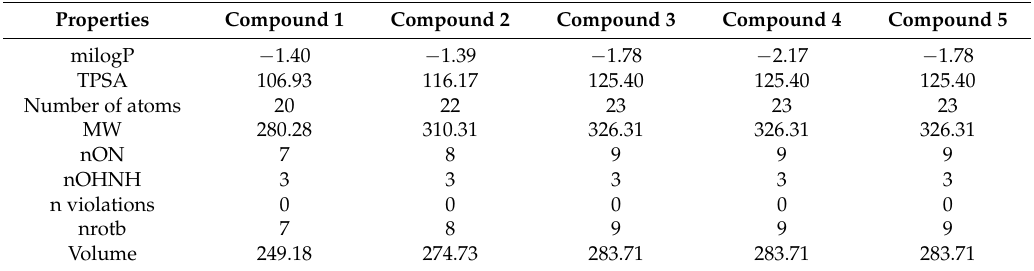
Table 1. Molinspiration-calculated properties of iminodiacetic acid derivatives.